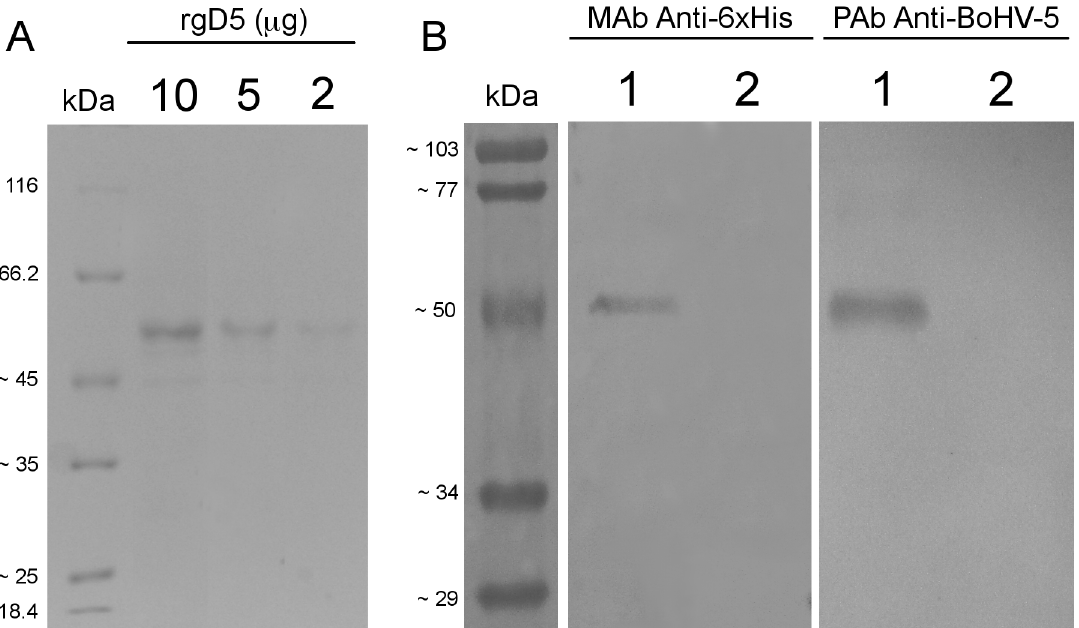
Fig 1. Coomassie Blue Staining and Western Blot Analysis of the Purified rgD5. (A) After purification steps, different concentrations of purified rgD5 protein (55 kDa) were separated by SDS-PAGE in a 12% gel and stained overnight with Coomassie Blue R-250. Lane kDa: Unstained Protein MW Marker (Fermentas/Thermo Fisher Scientific); Lane 10: 10 μ g rgD5; Lane 5: 5 μ g rgD5; Lane 2: 2 μ g of rgD5; (B) Western blot was performed with mouse monoclonal antibody (MAb) Anti-6xHis HRP conjugated (Anti-6xHis) or with polyclonal antibodies (PAb) from bovine immunized with inactivated BoHV-5 (Anti-BoHV-5). Lane M: Prestained Low Range Protein MW Standard (Bio-Rad); Lane 1: Purified rgD5; Lane 2: KM71H supernatant of non-transformed yeast cells after methanol induction used as negative control.